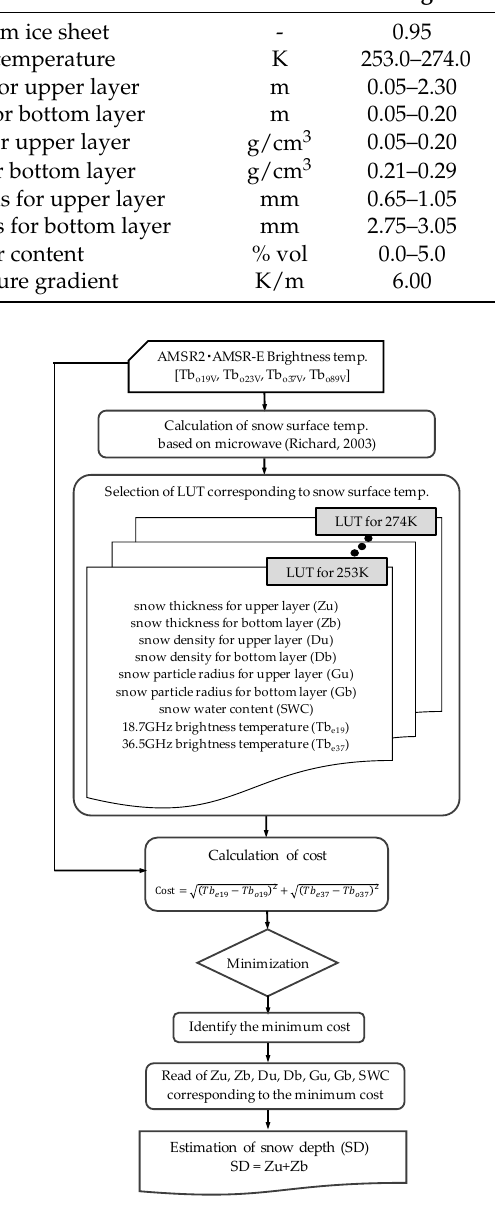
Figure 7. Flow path of the simple snow retrieval algorithm used for estimating snow depth on the Greenland Ice Sheet (GrIS). LUT = lookup table; AMSR-E = Advanced microwave scanning radiometer aboard the NASA Aqua satellite; AMSR2 = Advanced microwave scanning radiometer aboard the GCOM-W1 satellite.